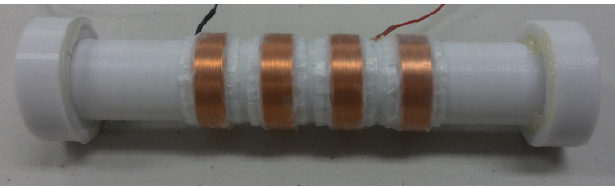
Figure 4. Developed nonlinear energy